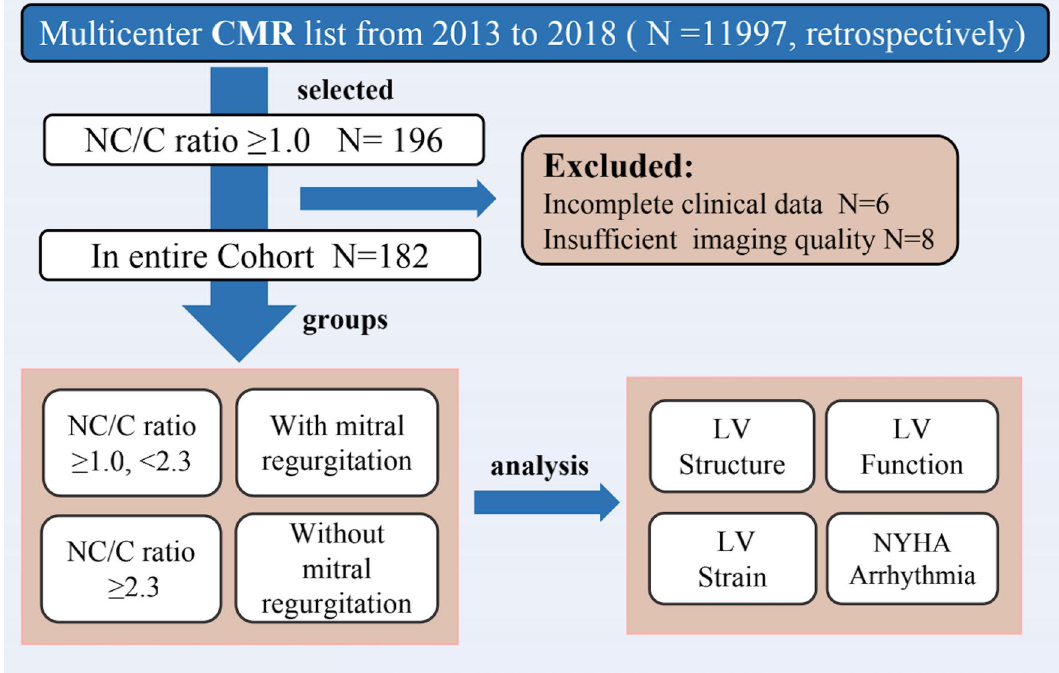
Figure 1. The flowchart of patient selection and implementation for the study. CMR cardiovascular magnetic resonance, NC/C noncompaction/compacted, LV left ventricular, NYHA New York Heart